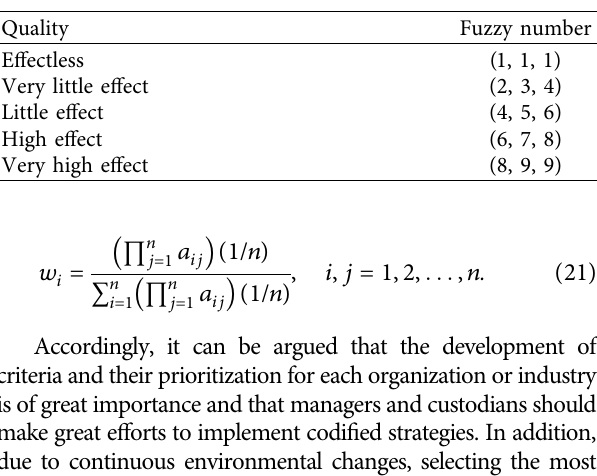
Table 2: Variables and corresponding fuzzy numbers.